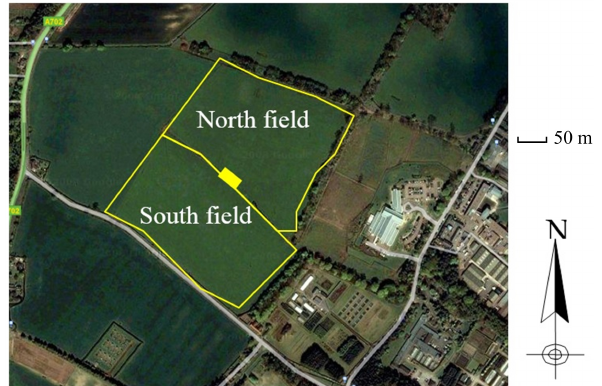
Figure 6. Satellite photo of the Easter Bush site. The map was gen- erated by Google Maps, indicating the two halves of the field and the place of the instruments on the border of the two denoted by the small yellow rectangle. (The figure is taken from the metadata file by